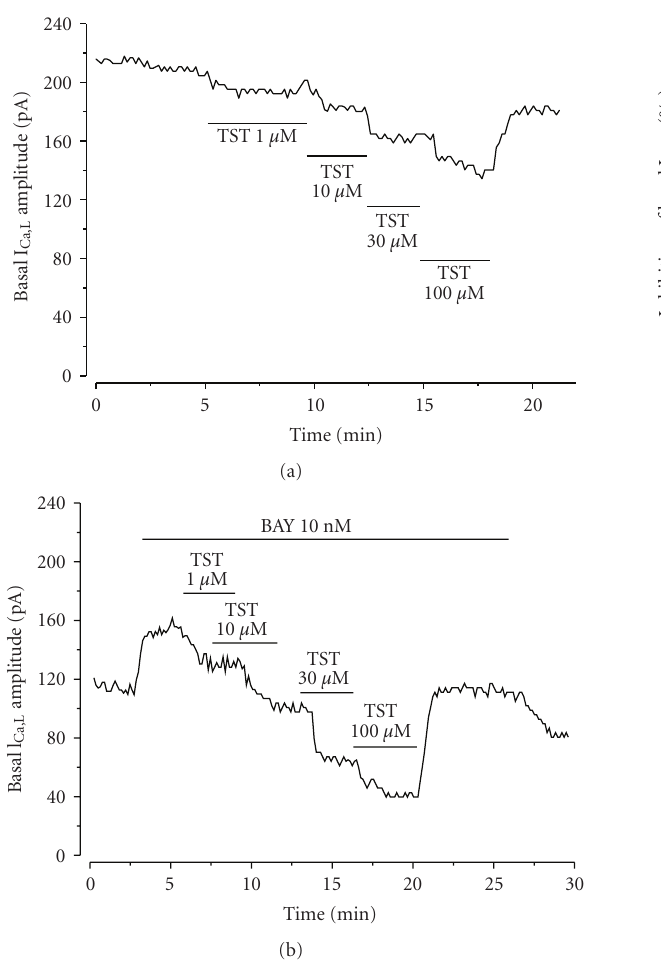
Figure 4: E ff ect of testosterone on I Ca,L amplitude in A7r5 cells. Original records of I Ca,L measured in Patch-clamp experiments showing that increasing concentrations of testosterone (TST; 10- 100 μ M) inhibit basal I Ca,L (a) and BAY-stimulated I Ca,L (b).